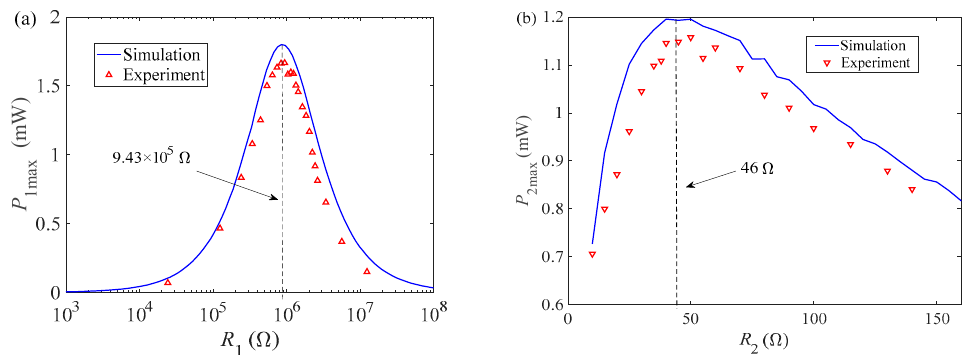
Figure 13. Output power curve with the load resistances. ( a ) Comparison between R 1 optimal load experimental value and numerical analysis value ( b ) R 2 optimal load experimental value and numerical analysis value comparison.